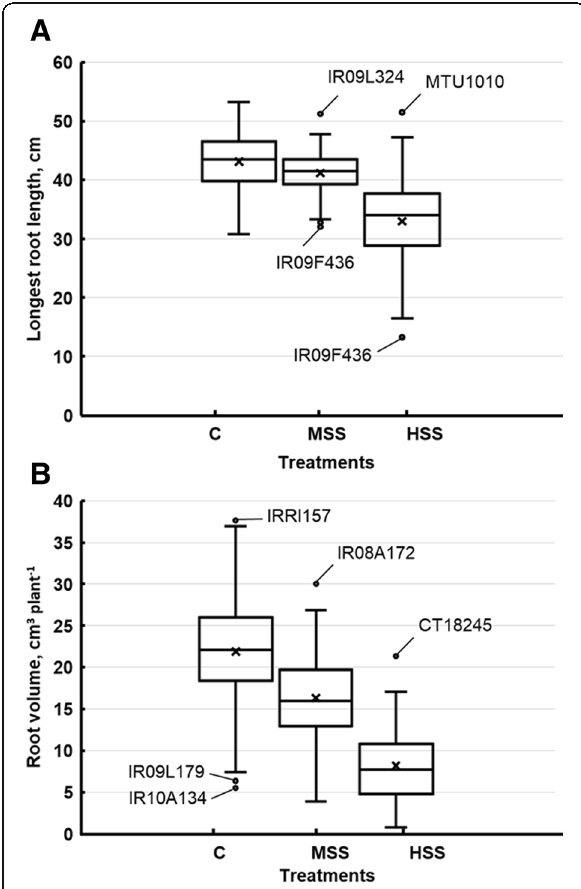
Fig. 2 Box and whisker plots for root growth and development traits showing natural variation and the effect of different salinity treatments on the average ( a ) longest root length, cm plant − 1 and ( b ) root volume, cm 3 plant − 1 . The genotypes below the first quartile or above the third quartile are representing outliers in individual traits, are also indicated